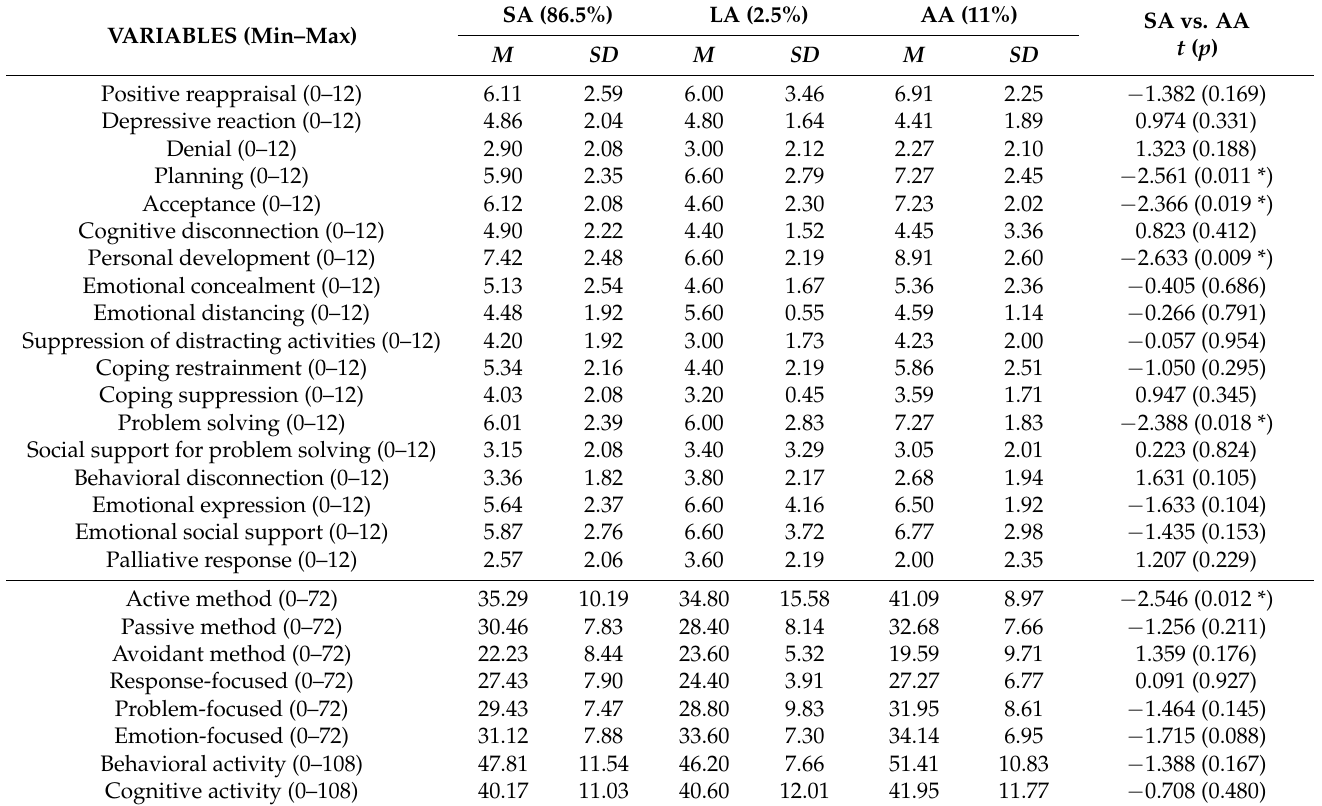
Table 3. Descriptive findings and mean comparisons (Student’s t tests) for the coping strategies and styles by physical